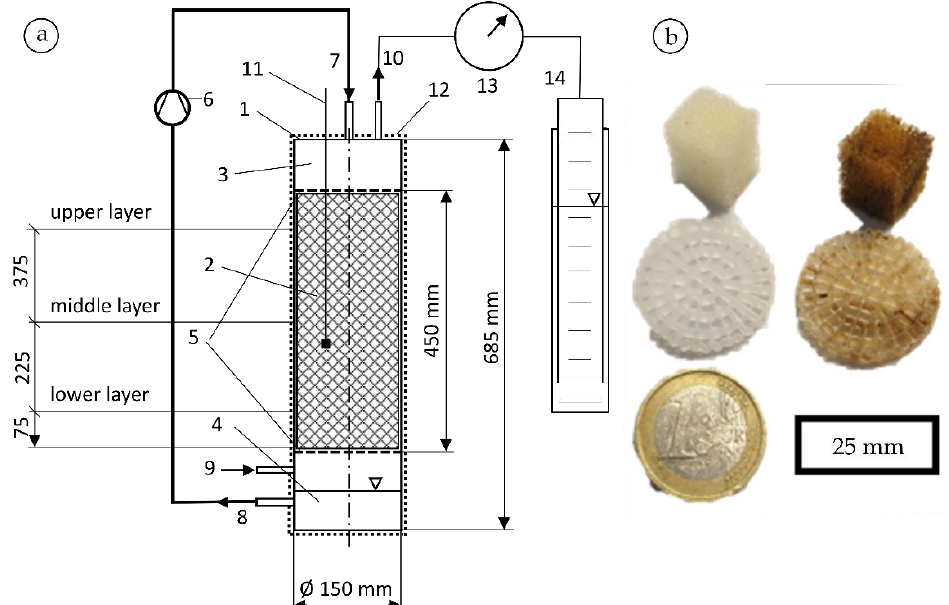
Figure 1. ( a ) Scheme of the biofilm reactor, including three (upper, middle, lower) sampling layers: (1) biofilm reactor, (2) trickle bed 8 L bulk volume, (3) gas compartment 1 L volume, (4) reservoirs of liquid 1 L volume, (5) wire mesh, (6) liquid circulation pump, (7) liquid inlet, (8) liquid outlet, (9) biogas inlet (raw gas from anaerobic digester), (10) upgraded gas outlet, (11) temperature sensor, (12) electric heating jacket and insolation, (13) drum gas counter, (14) swimming gas storage. ( b ) Linpor ® PU-foam cube and PE-10 biofilm carriers, left new, right after biofilm formation (day 105). The inoculum was sieved with a mesh width of 1 mm to remove particles to prevent mechanical damage and clogging of the pipes. For the inoculation, the inoculation sludge was pumped over the biofilm carriers in a circle for 5 days using the liquid circulation pump, after which the excess sludge was removed from the liquid reservoir. At the begin- ning of the inoculation phase, the biofilm reactor was flushed with five times the reactor volume of methane to guarantee anaerobic conditions. After each reactor opening for sam- pling, the reactor also was flushed with methane. The CH 4 , CO 2 , O 2 , H 2, and H 2 S concentration in the gas in- and outlet was measured daily, and during the gas flushing of the reactor using a hand probe (Gas Data GFM 430, Shawcity Limited, Coventry, England), the measurement accuracy is specified as 3% by the manufacturer at 100% CO 2 and CH 4 . The gas volume was measured using a drum gas counter (TG0.5/5 PVC, Dr.-Ing. Ritter Apparatebau GmbH, Bochum, Germany). The reac- tor temperature was measured and controlled using a platin temperature sensor and tem- perature controller (STC-1000 Pro, Diymore, Shenzhen, China) connected to an electrical heat jacket (HK-5.0, 75 W, Arnold Rak Wärmetechnik, Frankfurt, Germany). The reactor was supplied with biogas from an experimental plant; the raw biogas composition and the product gas composition was measured daily. The hydrogen